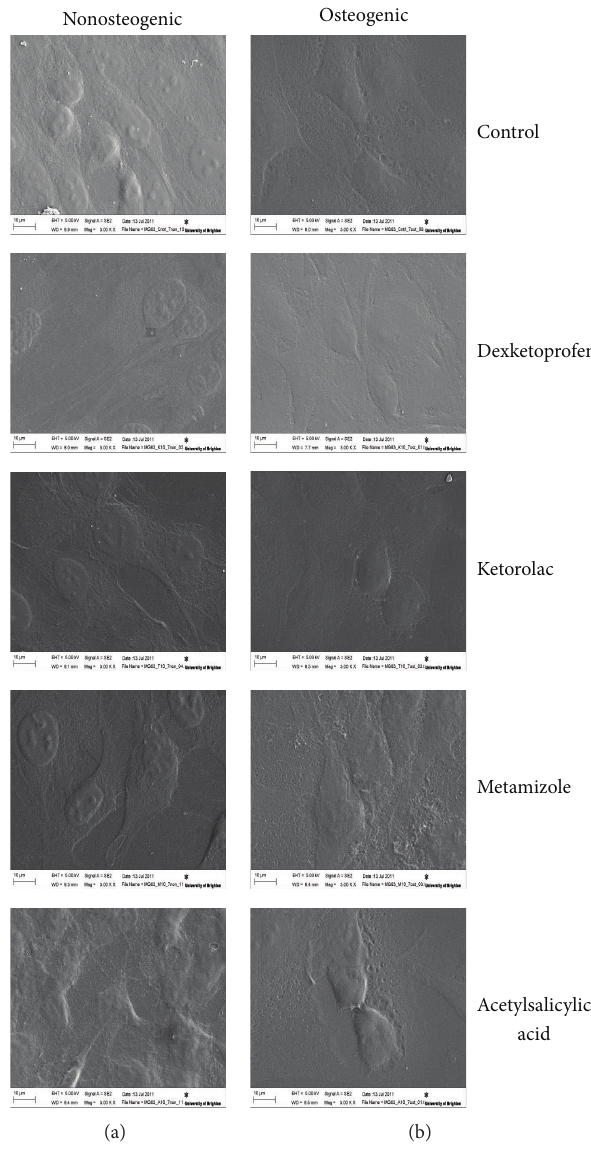
Figure 5: SEM: Effect of NSAIDs on collagen synthesis; cells were incubated in nonosteogenic and osteogenic mediums and treated at a dose of 10 𝜇 M, for 7